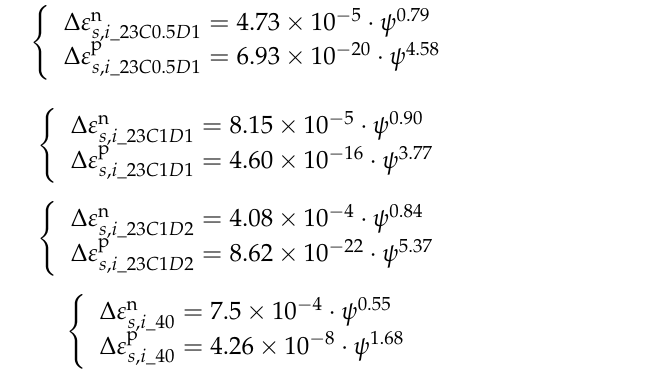
Figure 5. Validation of new battery discharge heat generation power under adiabatic conditions. Figure 6 depicts the calculated findings of battery capacity decline under various op- erating conditions and the testing results. At the end of the age, when the battery was cycled at 23 °C C1D1 and 23 °C C1D2 working conditions, there was a dramatic decline in capacity. Lithium precipitation from the negative electrode and an increase in the rate of electrode active material loss could both be the real causes of the abrupt decline in ca- pacity [31]. 0 ( b ) Figure 6. Validation of battery capacity under different conditions of cycle aging at ( a ) 23 °C and ( b ) 40 °C.